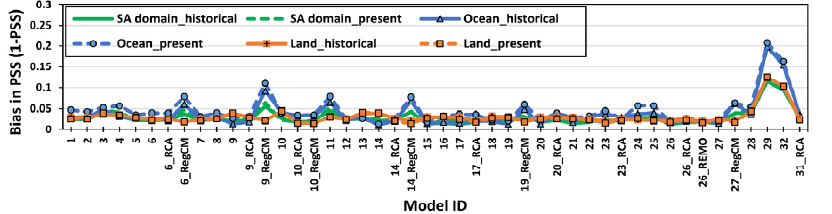
Figure 2. Assessment Criteria Statistic (ASC) summary of CMIP5 GCMs and CORDEX RCMs in reproducing frequency distribution of daily mean wind speed over South Asian (SA) domain for historical period (1979–2005) (green solid line), over SA domain for present period (2006–2019) (green dashed line), over ocean for historical period (blue solid line with triangle markers), over ocean for present period (blue dashed line with circle markers), over land for the historical period (orange solid line with plus sign markers) and over land for present period (orange dash line with square markers); ASC (Bias in Perkins Skill Score ( B PSS )) on y-axis and Model ID on